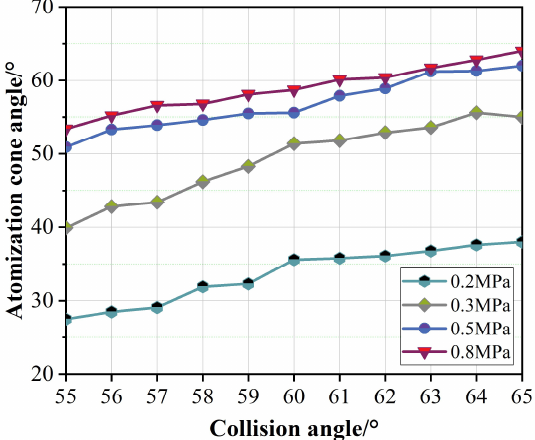
Figure 14. Variation curve of atomization cone angle with the collision angle under different spray pressures.